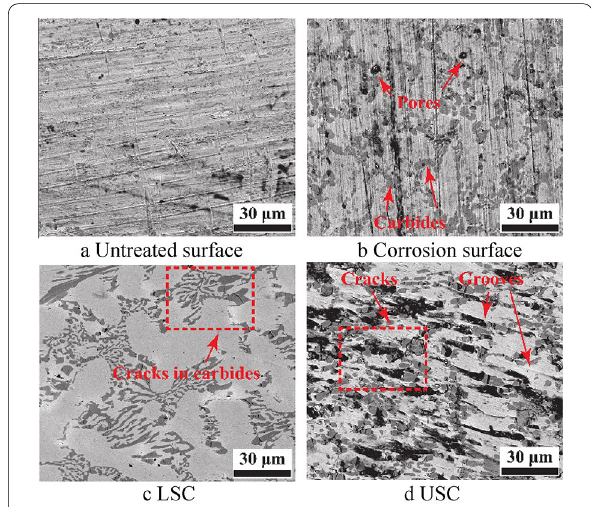
Figure 12 Degradation morphologies of the movable latch in various